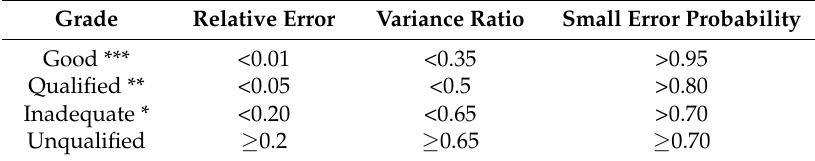
Table 1. Grey Prediction Model’s precision standard.